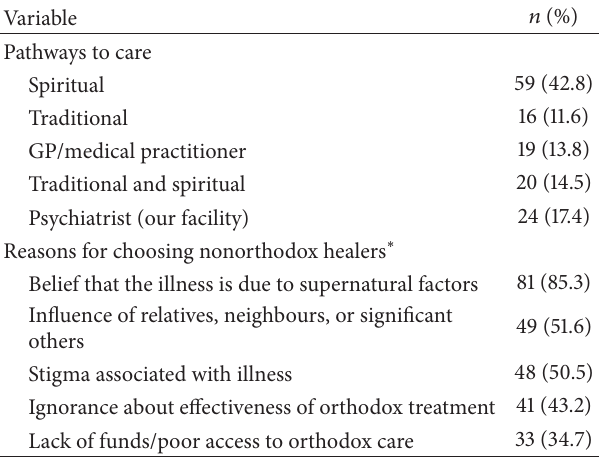
Table 2: Pathways to care and reasons for choosing nonorthodox +